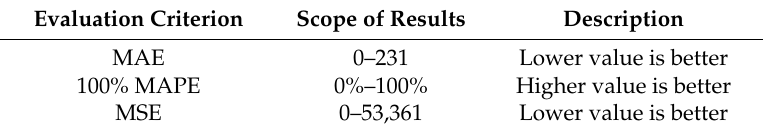
Table 7. Scope of error that can be calculated by MAE and MSE, and accuracy by